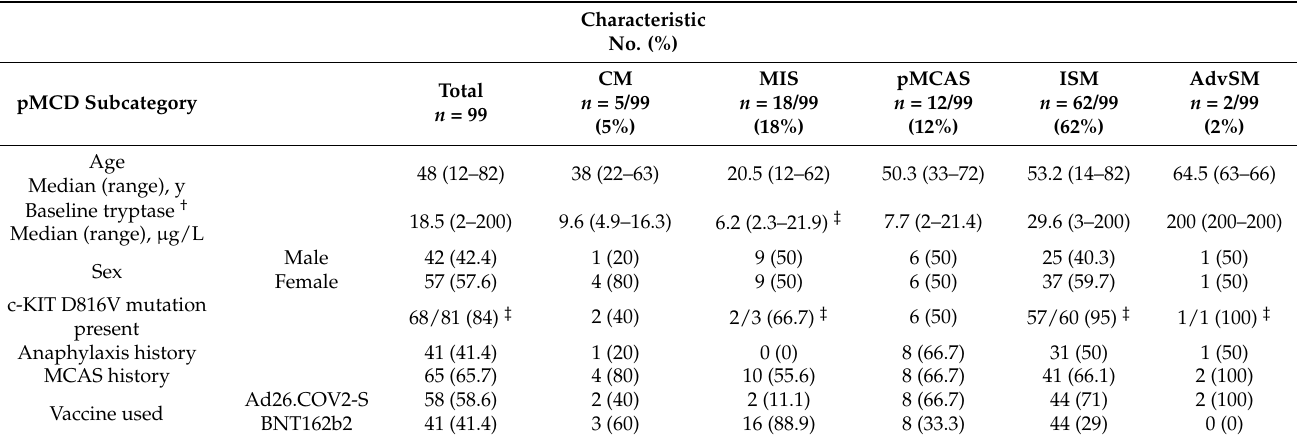
Table 2. Baseline characteristics of primary mast cell disease patients.